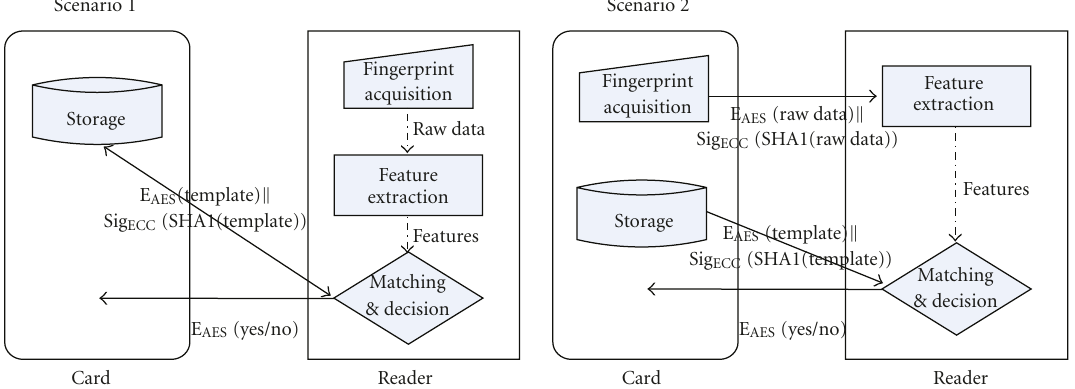
Figure 1: Illustration of the integrating scenarios [23–26] for store-on-card and the corresponding X9.84 [27] implementations.